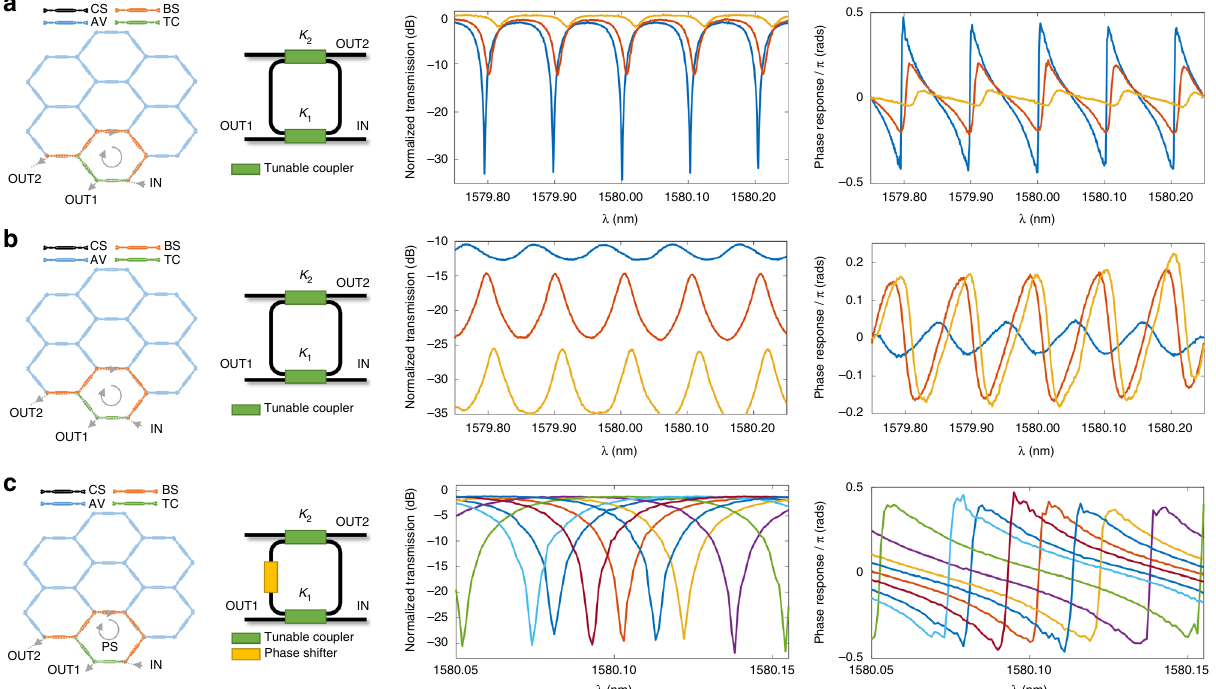
Fig. 4 Experimental results for 6-BUL ring resonator in fi nite impulse response and combined fi nite impulse response and in fi nite impulse response fi lters. Waveguide mesh connection diagram, circuit layout and measured modulus, and phase transfer function for a a 6-BUL optical ring resonator ( ORR ) in fi nite impulse response ( IIR ) fi lter for different values of the coupling constants K 1 and K 2 ; b a 6-BUL ORR fi nite impulse response (FIR) + IIR fi lter for different values of the coupling constants K 1 and K 2 ; c a 6-BUL ORR IIR fi lter along a full spectral period for different values of the optical ring resonator round-trip phase shift. BUL, basic unit length; CS, cross state; BS, bar state; AV, available; TC, tuneable